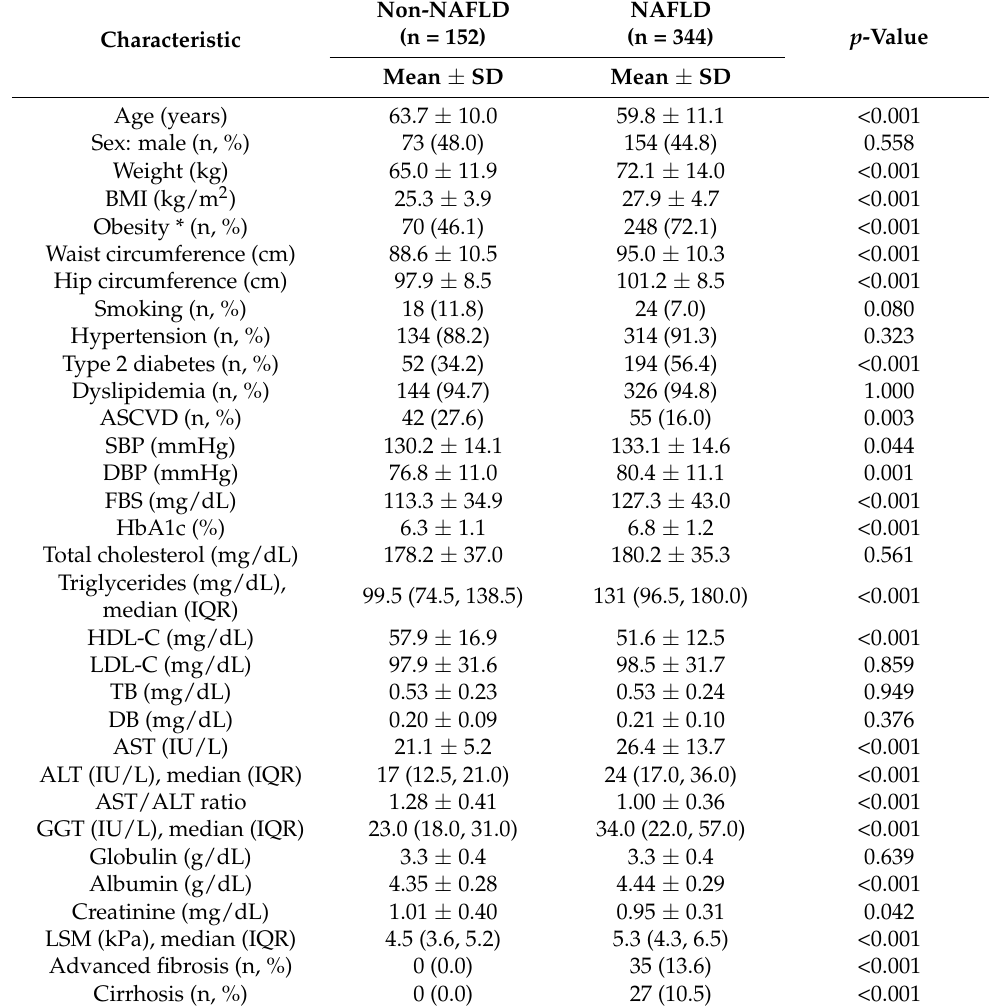
Table 1. Baseline clinical characteristics of patients with and without nonalcoholic fatty liver disease.